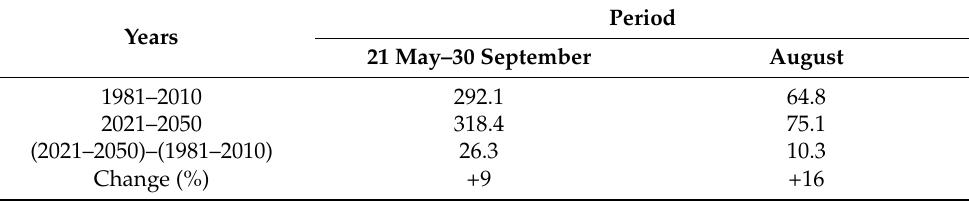
Table 6. Comparison of the Jerusalem artichoke water needs (mm) in the reference and forecast